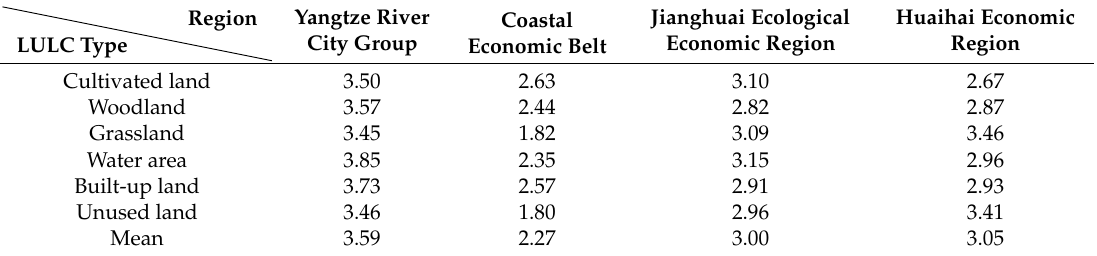
Table 3. The soil organic carbon (SOC) densities of different LULC types in the four functional regions (kg/m 2 ).